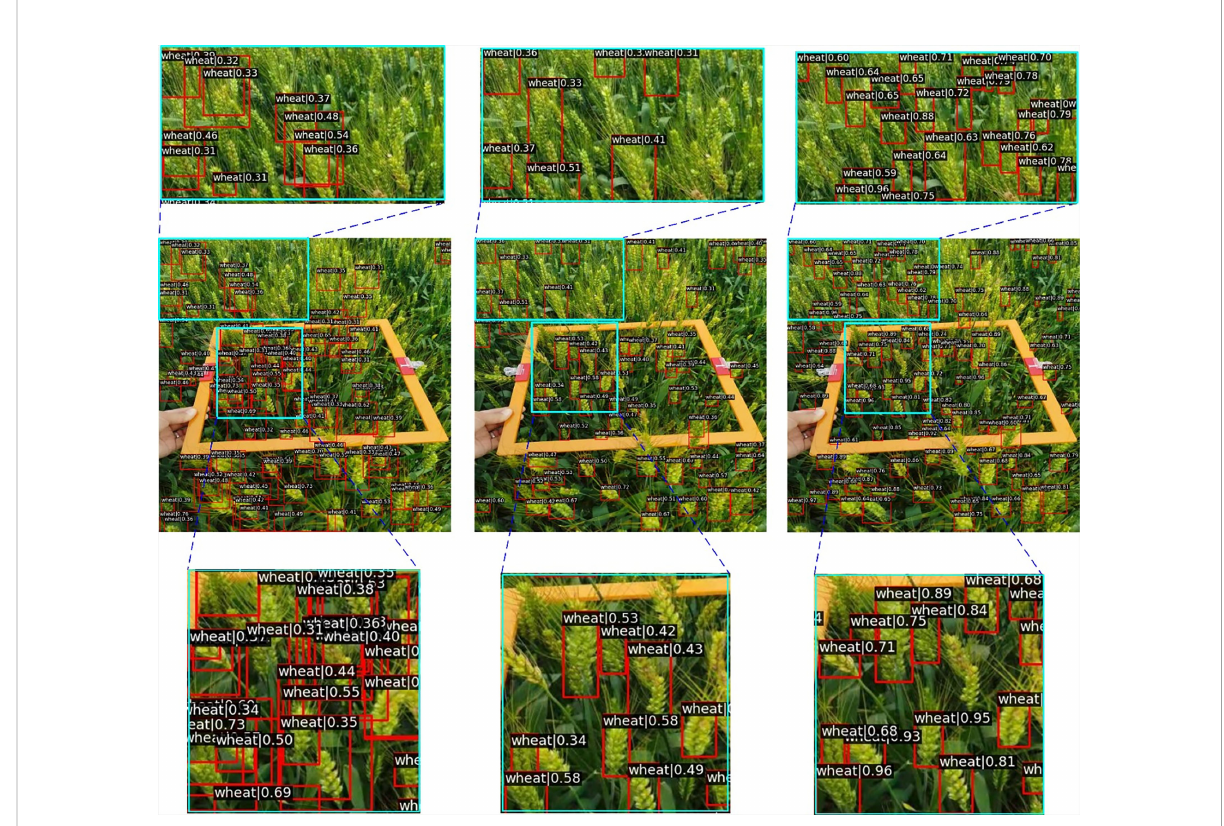
FIGURE 5 Visualization of the comparative models. The left column represents the result of Faster R-CNN, the middle column represents the result of YOLOv3, and the right column represents the result of